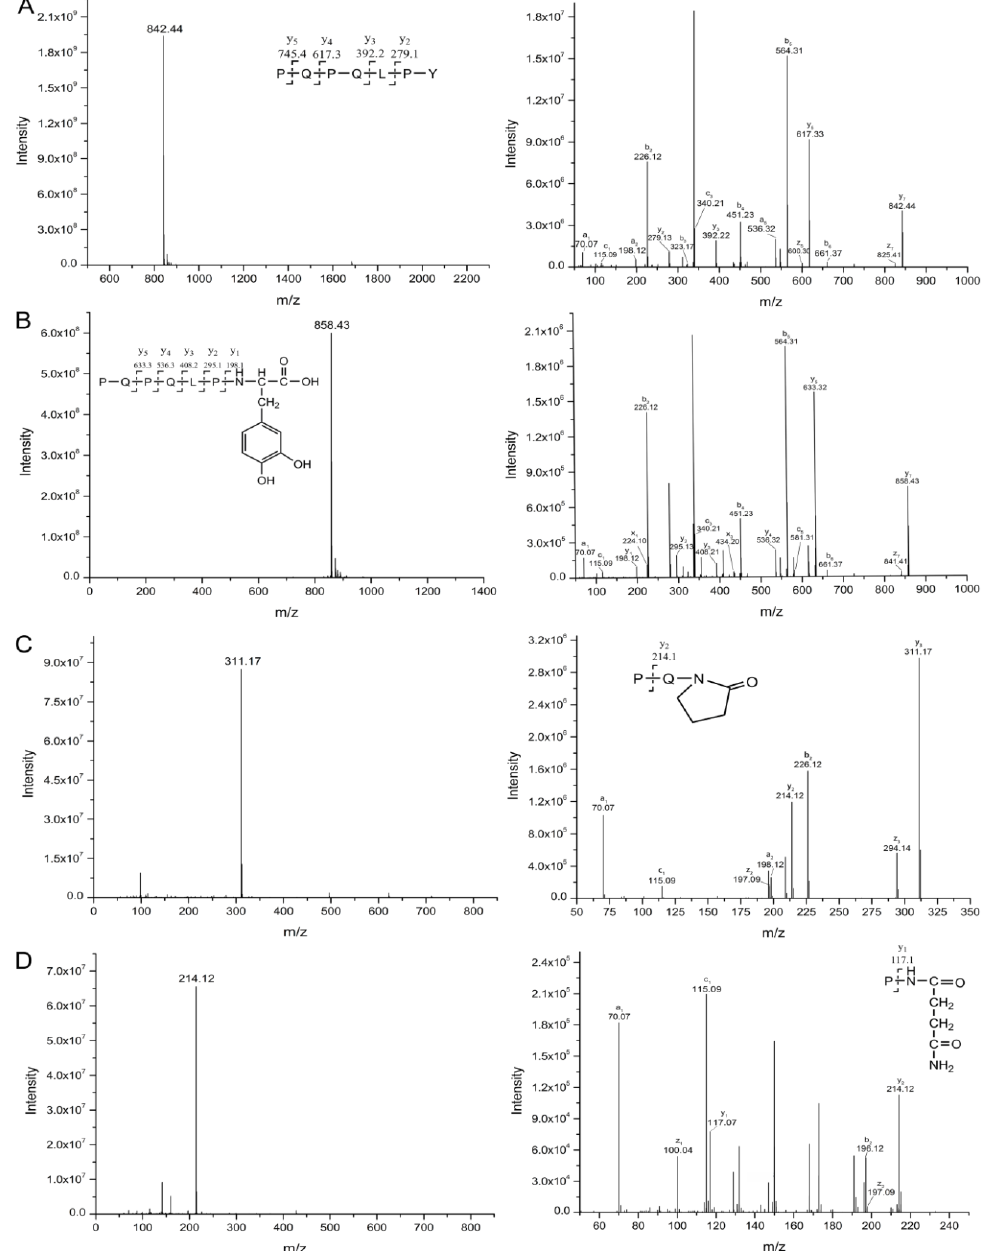
Figure 5. Full-scan MS and representative MS / MS spectra of PQPQLPY and its products (P5~P7) during plasma treatment, showing evidence for • OH-mediated modification. In each panel, the left spectrum shows the full scan, while the right spectrum shows the fragment ions. The b and y ions originated from preferential cleavage at the N-terminus and C-terminus of specific amino acid residues during collision-induced dissociation, respectively. ( A ) Original peptide (842.4 m / z ); ( B ) product 5 (858.4 m / z ); ( C ) product 6 (311.7 m / z ); ( D ) product 7 (214.1 m / z ).